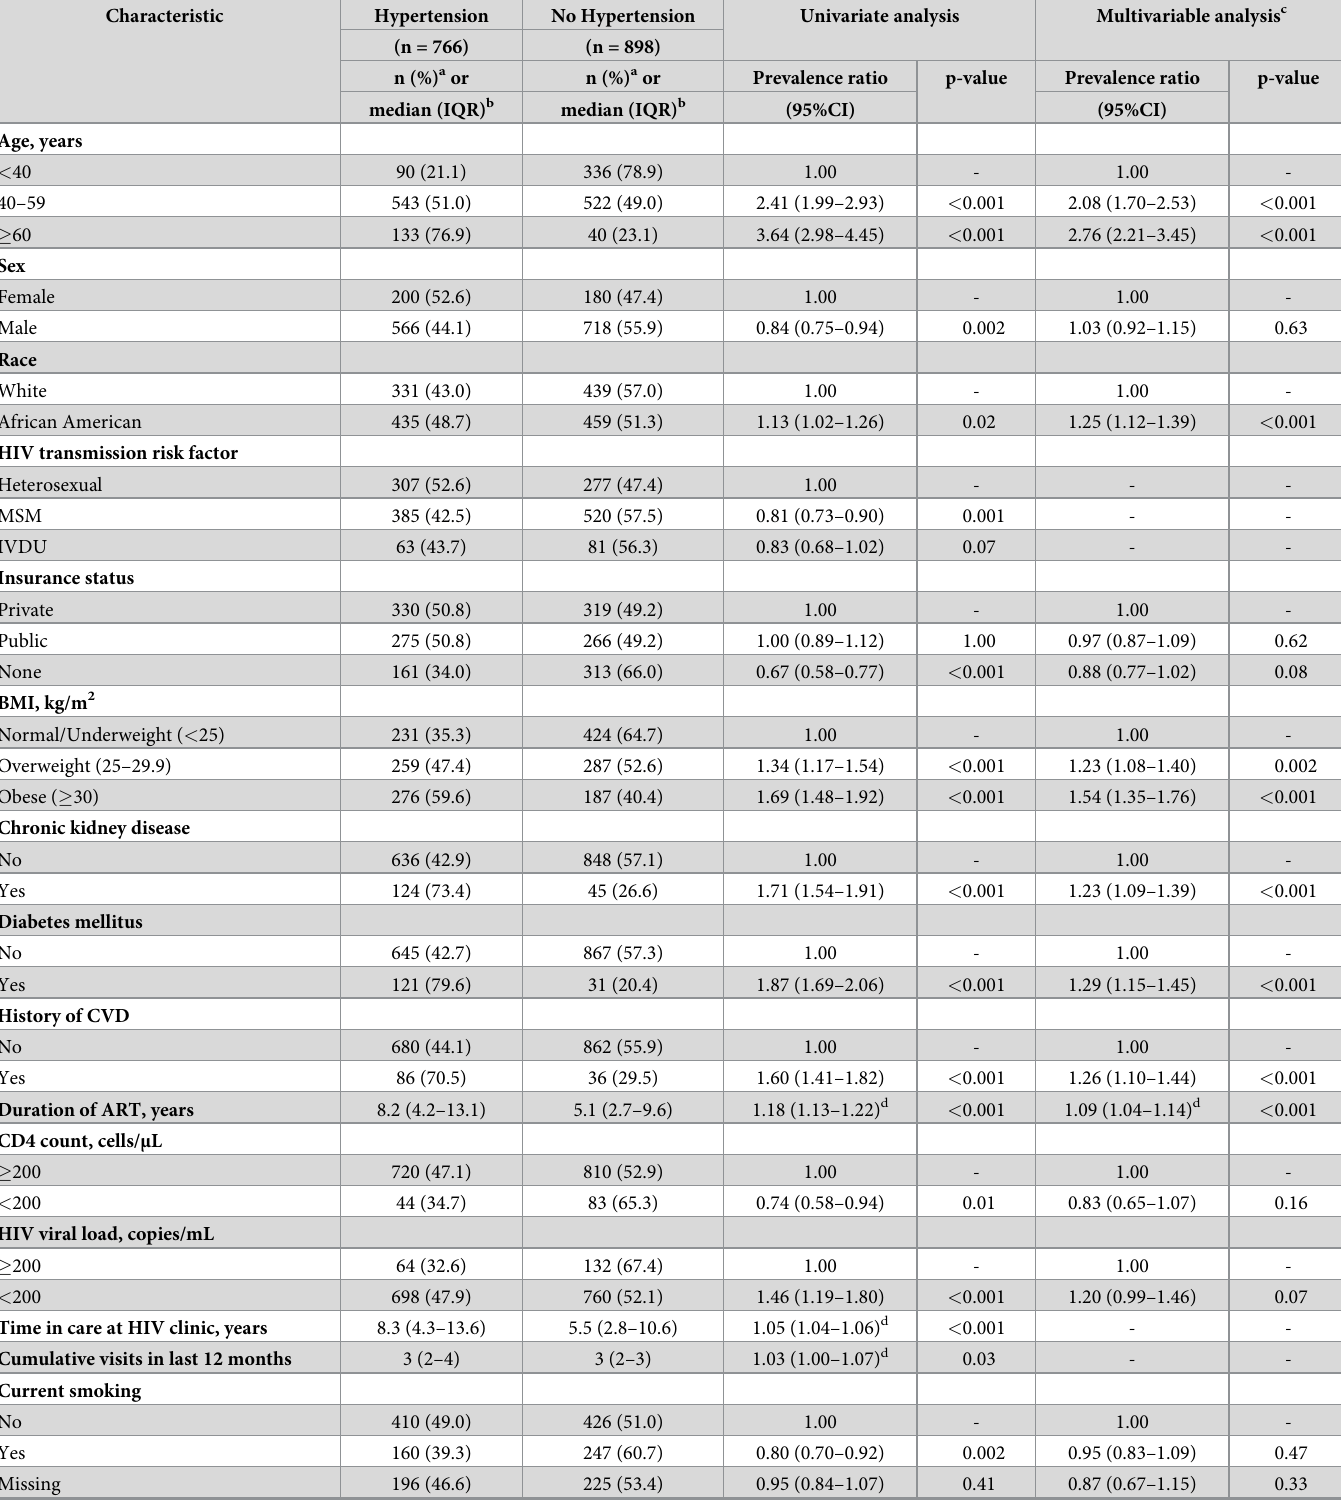
Table 2. Characteristics associated with prevalence of hypertension among 1,664 HIV-infected patients attending the UAB 1917 HIV Clinic in 2013.